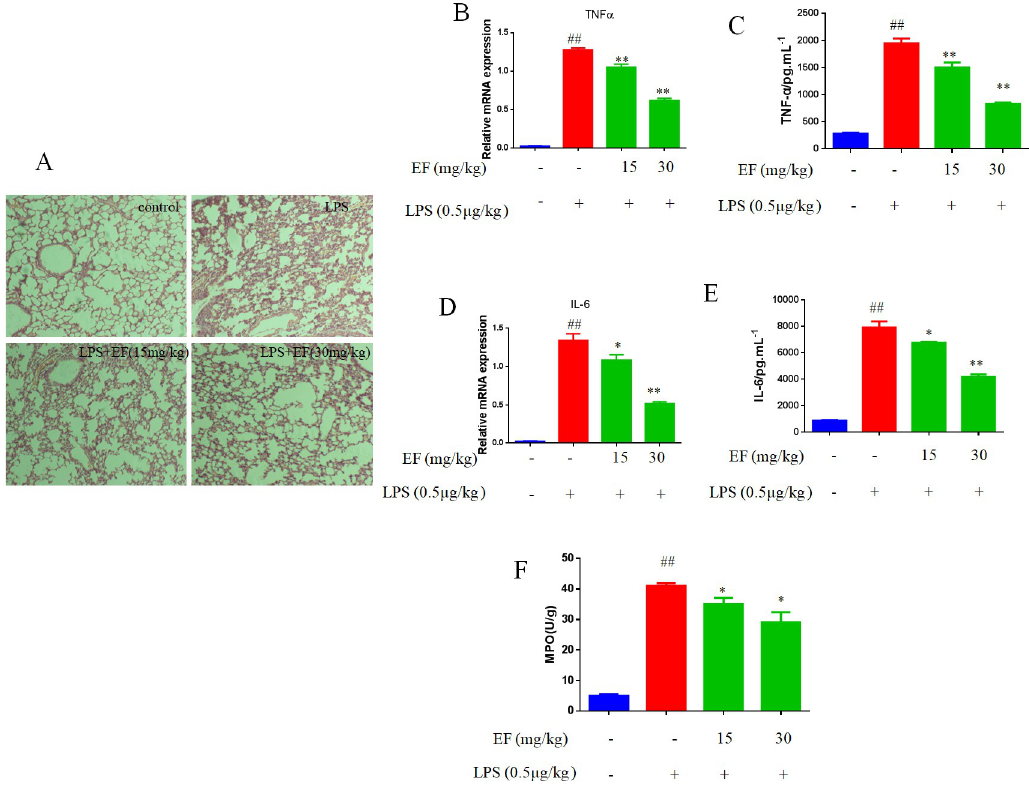
Fig 9. Effect of EF on LPS-induced acute lung injury in mice. A: lungs from different groups were processed for histological evaluation 8 h after the LPS. B/D: The mRNA levels of TNF α and IL-6 were determined by quantitative real-time PCR. C/E: The BALF levels of TNF- α , IL-6 and IL-1 β , determined by ELISA. #P < 0.05, ##P < 0.01 vs control; � P < 0.05, �� P < 0.01 vs LPS.